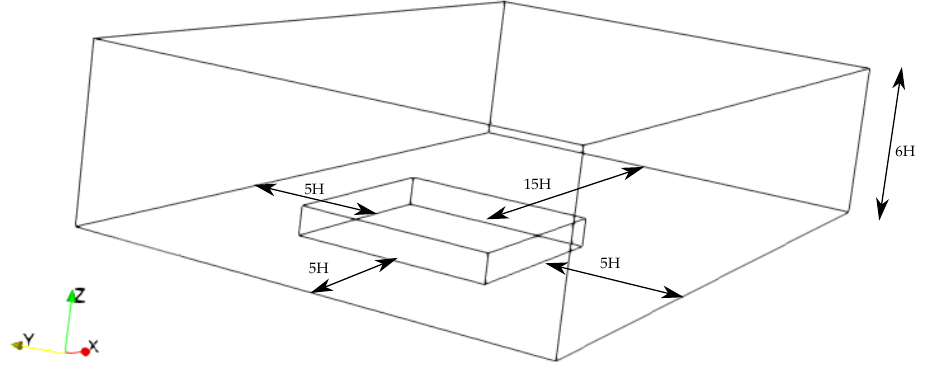
Figure 1. Initial simulation domain for a city block (validation